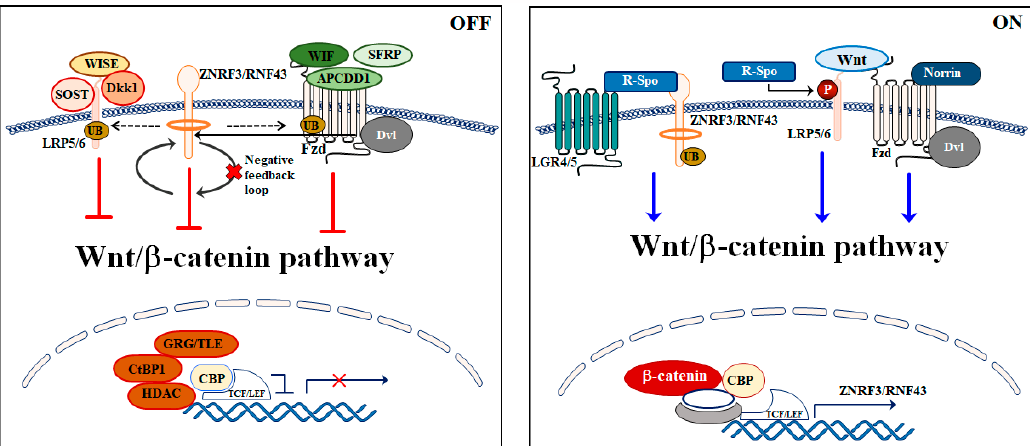
Figure 2. Schematic representation of the regulation of the Wnt / β -catenin signaling pathway when it is inactive (OFF) and when it is active (ON). OFF: ZNRF3 and RNF43 are transmembrane molecules that downregulate Wnt / β -catenin signaling. They promote the ubiquitination (UB) and lysosomal degradation of Fzd and LRP5 / 6. Secreted SFRP, APCDD1, and WIF can directly bind Fzd to prevent activation of receptors. Other Wnt antagonists, Dkk1 and Wise, inhibit by binding to the co-receptors LRP5 / 6. GRG / TLE, CtBP1, and HDAC negatively control Wnt / β -catenin pathway binding to TCF. ON: The Wnt agonists R-spondins interact on the cell surface with members of the LGR4 / 5 family to enhance Wnt signaling. Binding of R-spondin to ZNRF3 / RNF43 inhibits ZNRF3, which enhances the Wnt / β -catenin pathway activity. Norrin acts by interacting with Fzd4 and requiring LRP5 / 6 for its activation. Arrows show activation while T-bars show inhibition.